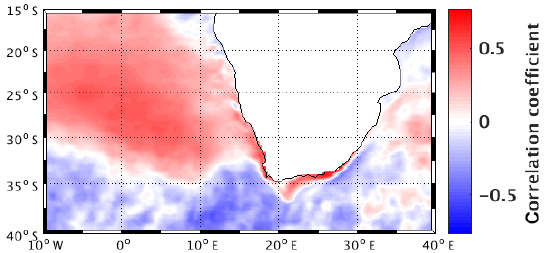
Figure 6. Correlation pattern of the sea surface temperature in the INALT20 simulation and the position of the trades from the COREv2 reanalysis in December–February over the period 1958–